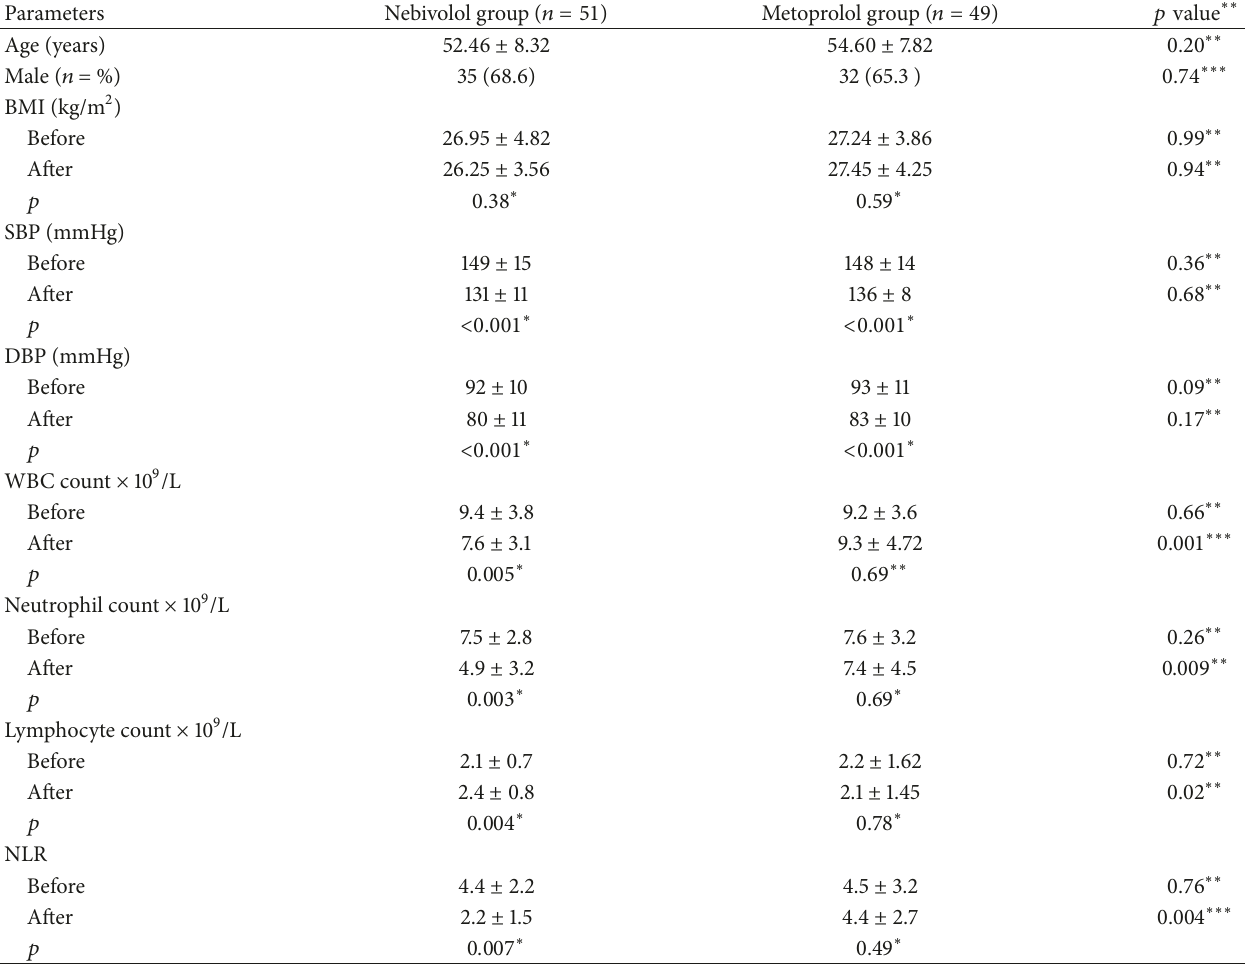
Table 1: Comparison of baseline characteristics and inflammatory parameters between two